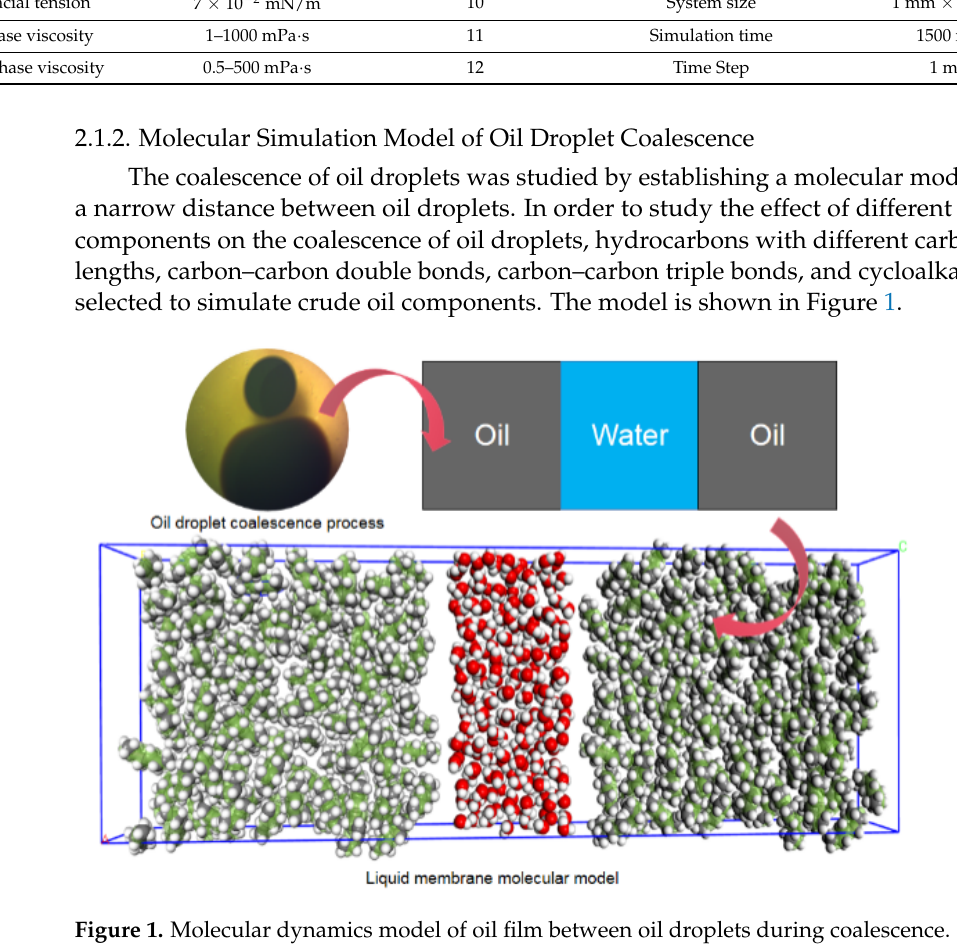
Figure 1. Molecular dynamics model of oil film between oil droplets during coalescence.